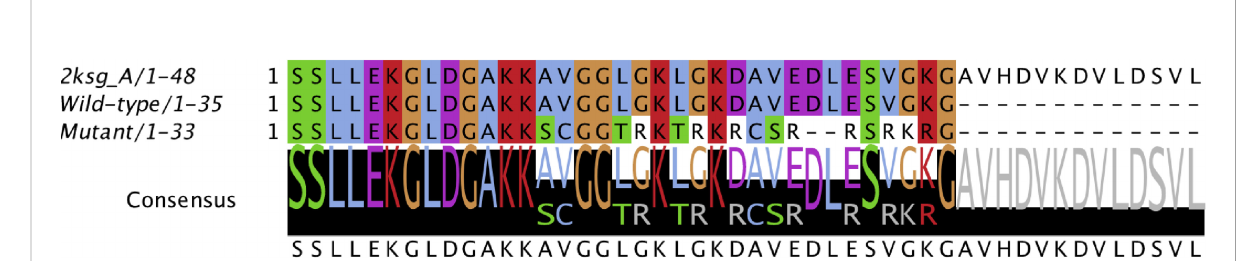
FIGURE 3 Alignment of the conserved domain of active dermcidin peptide. Conserved amino acid residues are highlighted. The black bars with letters at the bottom represent the conservation level and consensus sequence (with their possible amino acid variations). Structure of dermcidin human available on the Protein Data Bank (PDB ID: